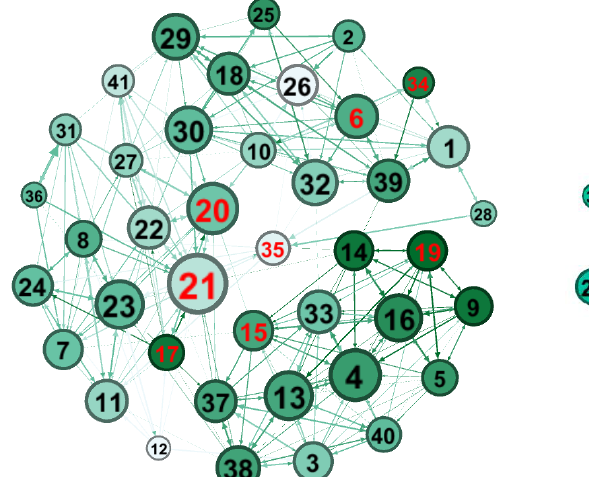
10 of 17 Figure 3. The relationship between weighted indegree of friendship network and weighted indegree of peer tutor networks. The green nodes represent outliers in the scatter plot. There are four outliers (green nodes) in Figure 3 and they are nodes 6, 17, 21, and 34, representing four students with relatively high weighted indegree in the peer tutor net-